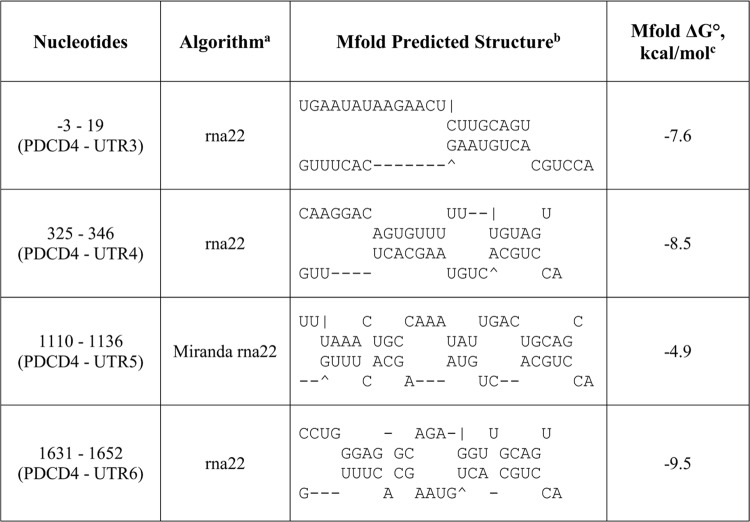
Predicted anti-miR-17-5p binding sites in the 3'UTR of PDCD4 mRNA as a mimic of miR-17-3p passenger strand.
aThe potential oncomiR:mRNA binding sites were identified by rna22, Targetscan, or miRanda. bTop strand is mRNA (5' ➔ 3') and the bottom strand is oncomiR (3' ➔ 5'). cCalculated at http://mfold.rna.albany.edu/?q=mfold.